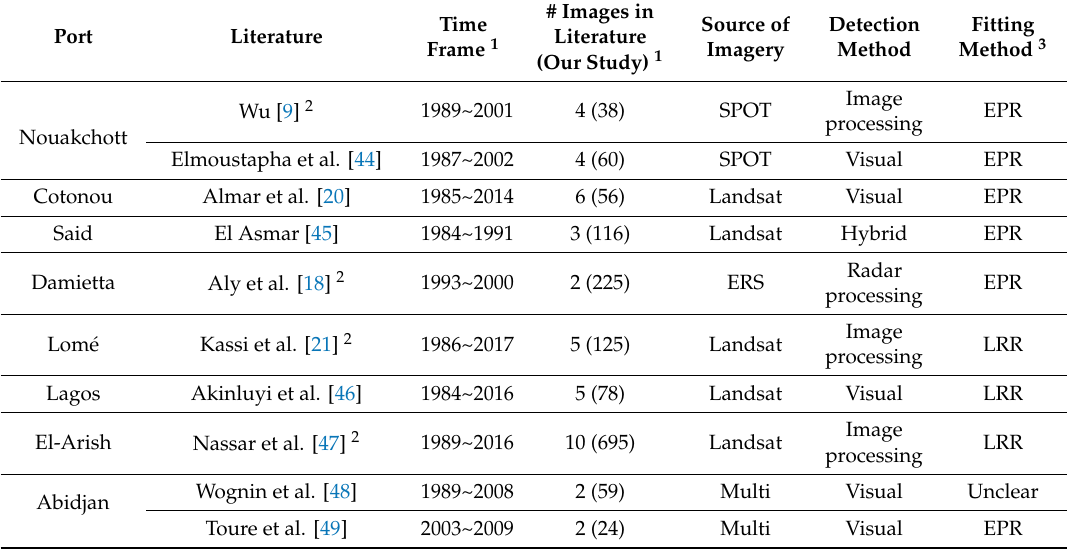
Table 7. Overview of available literature on the coastline evolution around ports with the considered time frame, number of analysed images, source of imagery, detection method, spatial analysis method, and fitting